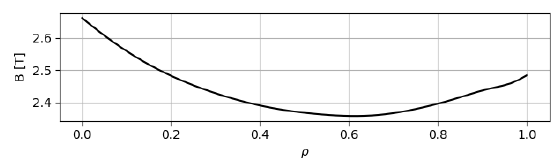
Figure 1. Magnetic field strength on midplane low field side for SPR-046. Note the minimum at ρ~0.6 and that the field is below the value at ρ = 1 for 0.2 < ρ < 1.0 .